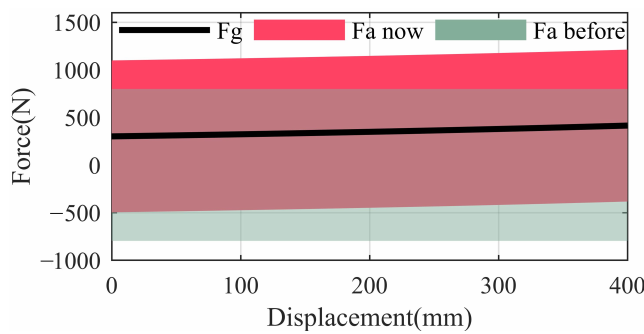
Figure 4. Effect of installing a gas spring in parallel with the actuator. Fg represents the output force of the gas spring; Fa now represents the force range of the PEA; and Fa before represents the original force range of the actuator. The extension force of the actuator is selected as positive force in this